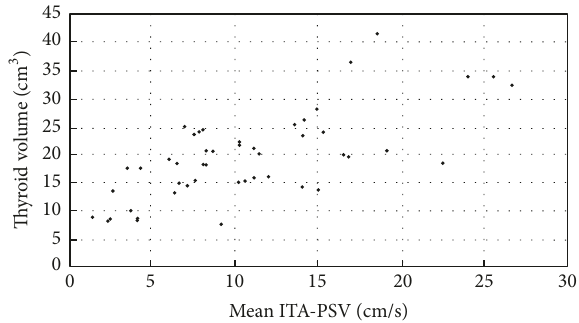
Figure 5: Scatterplot showing the relationship between the mean ITA-PSV (cm/s) and thyroid volume (cm 3 ): 𝑟 = 0.700 ; 𝑃 < 0.001